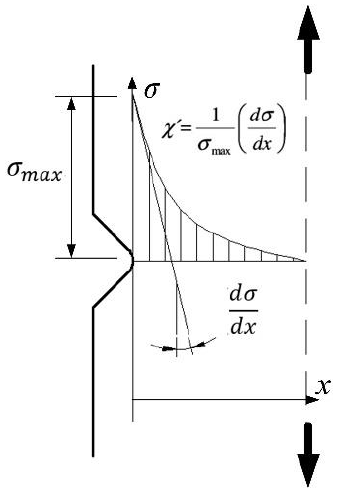
Figure 1. Stress gradient in notches caused by tension loading. Reproduced from [8], with copyright permission from Elsevier, 2002.